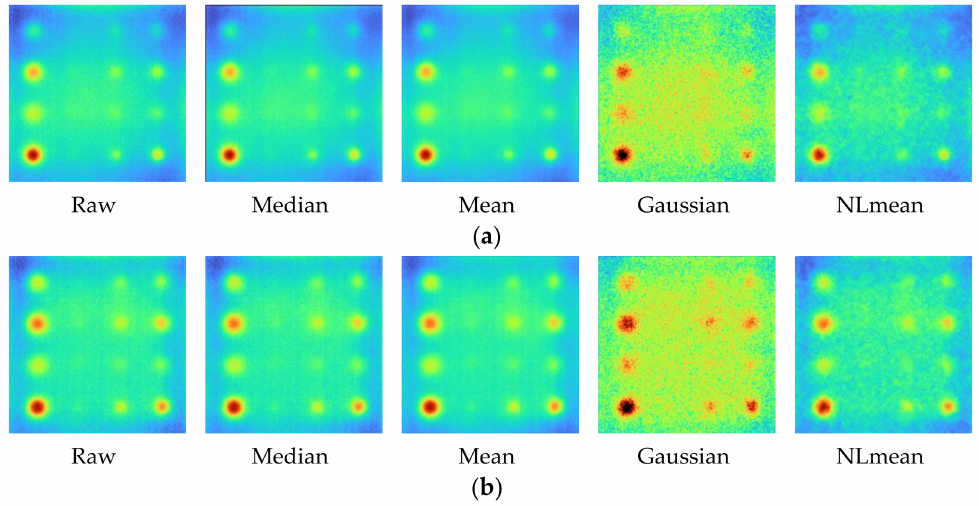
Figure 8. Images with filtering (median, mean, Gaussian, NLmean) applied to raw images for first de-noising: ( a ) amplitude and ( b ) phase.